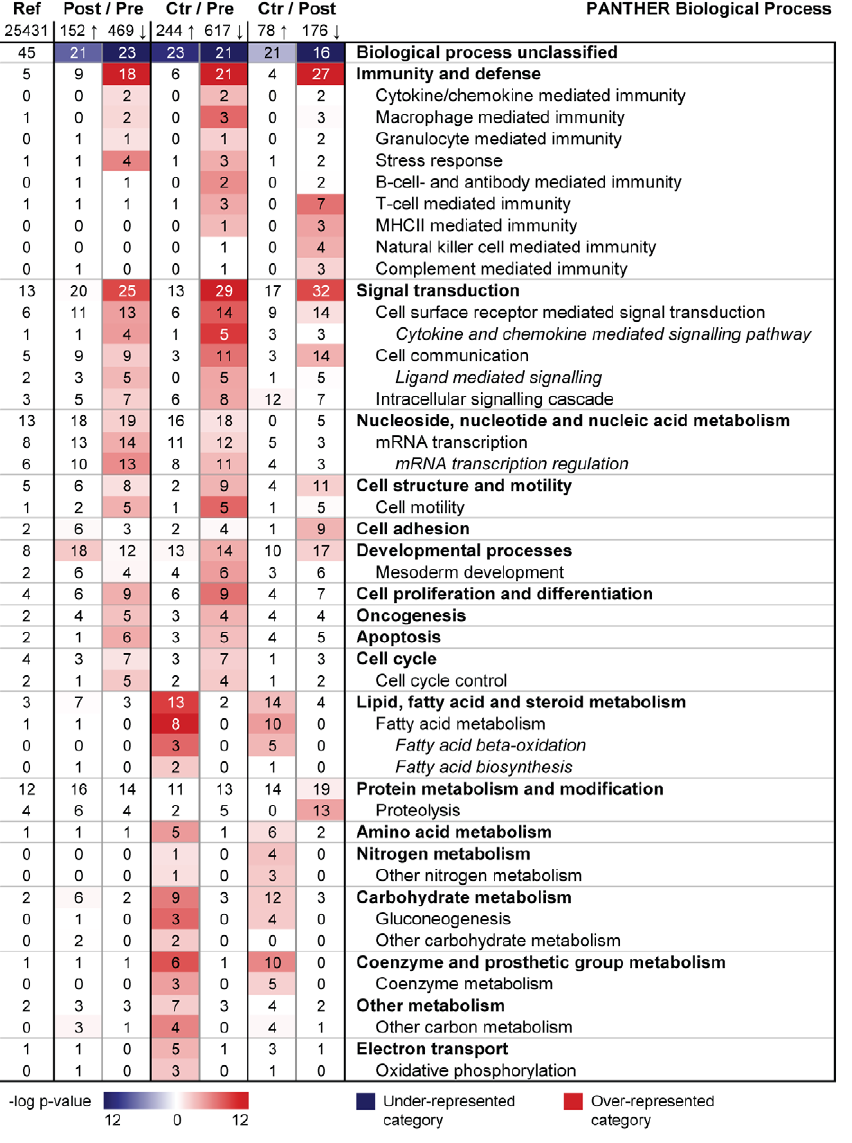
Figure 2. Functional categorization of differentially expressed genes in subcutaneous adipose tissue after fat loss (Biological Process). PANTHER was used to search for over-represented Biological Process categories among the most differentially expressed genes (q- value=0, fold change $ 1.5), comparing adipose tissue before versus after bariatric surgery (n=16) and versus controls (n=13). The color intensity displays the statistical significance ( 2 log p-value) of over- and under-represented PANTHER functional categories. A p-value , 0.01 with Bonferroni correction for multiple testing was used as inclusion criterion for categories. Numbers presented in the table indicate the percentage of genes within a gene set that map to the given category, e.g. 18% of the 469 down-regulated genes map to the biological process ‘Immunity and defense’. The first column states the overall distribution of a term among all human NCBI genes (25,431), e.g. 5% of the genes are expected to map to ‘Immunity and defense’, hence this category is significantly over-represented among the down-regulated genes. Ref, reference (based on all human NCBI